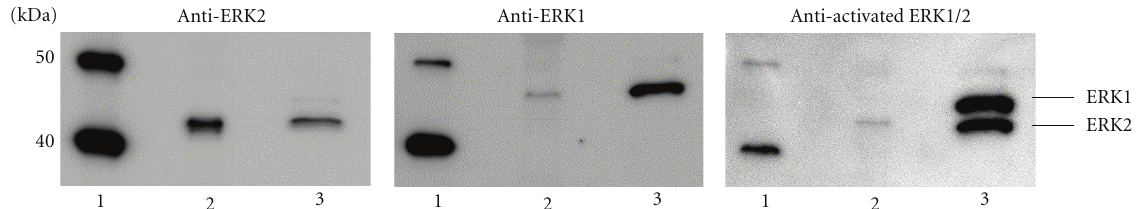
Figure 5: Detection of ERK1, ERK2, and doubly phosphorylated ERK2 in a pooled human CSF sample. Following prefractionation of 3.25mL of pooled CSF on an O ff -gel fractionator, the proteins with isoelectric points in the pH range from ∼ 6.5 to ∼ 8.5 were pooled, precipitated with trichloroacetic acid, and analyzed by SDS-PAGE/Western blot with the indicated antibodies. A sample corresponding to ∼ 0.54 mL of the original CSF-pool was loaded on each lane. (1) Magic mark protein standard, (2) CSF pool, (3) positive control (cell lysate of okadaic-acid-treated SH-SY5Y